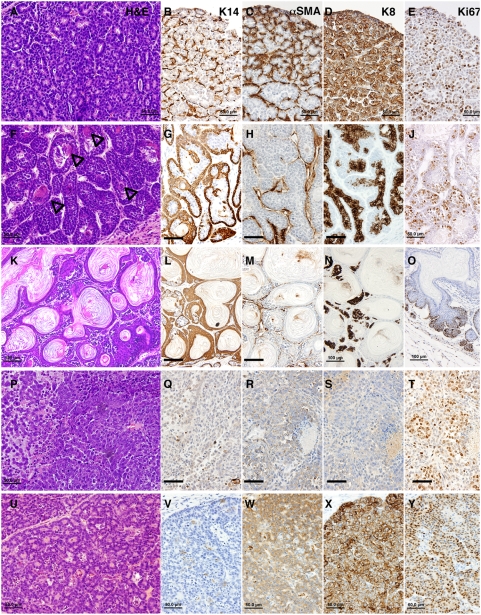
Histological heterogeneity in mammary tumors from K14-cre; ApcCKO/+ female mice.(A–E) Acinar tumor. (F–J) Basosquamous tumor with squamous metaplasia and ghost cells indicated by arrowheads. (K–O) Pilar tumor with extensive keratinization. (P–T) Undifferentiated tumor. (U–Y) Mammary tumor from a multiparous WAP-cre; ApcCKO/CKO female mouse. Stained with H&E for histology (A, F, K, P, U), K14 (B, G, L, Q, V), α-SMA (C, H, M, R, W), K8 (D, I, N, S, X) and Ki67 (E, J, O, T, Y) antibodies as indicated at the top. Note the different patterns of cell lineage markers associated with different tumor descriptors. Scale bars are 100 µm for K–O, the rest are 50 µm.